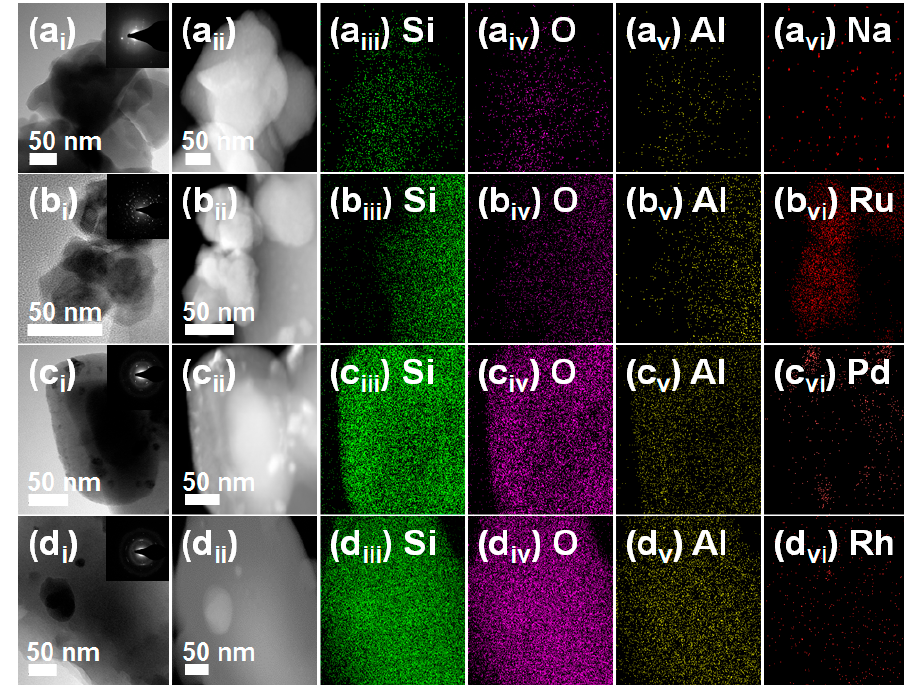
Figure 2. ( a – d ) i Transmission electron microscopy (TEM) images of NaMOR(cal), RuMOR(cal), PdMOR(cal) and RhMOR(cal), respectively, and their high-angle annular dark-field scanning transmission electron microscopy (HAADF-STEM) images (( a – d ) ii ) with corresponding selected area electron diffraction (SAED) patterns (inset). EDX elemental mapping images for ( a – d ) iii Si, ( a – d ) iv O and ( a – d ) v Al. EDX elemental mapping images in ( a – d ) vi correspond to Na, Ru, Pd, and Rh in NaMOR(cal), RuMOR(cal), PdMOR(cal), and RhMOR(cal) samples, respectively.